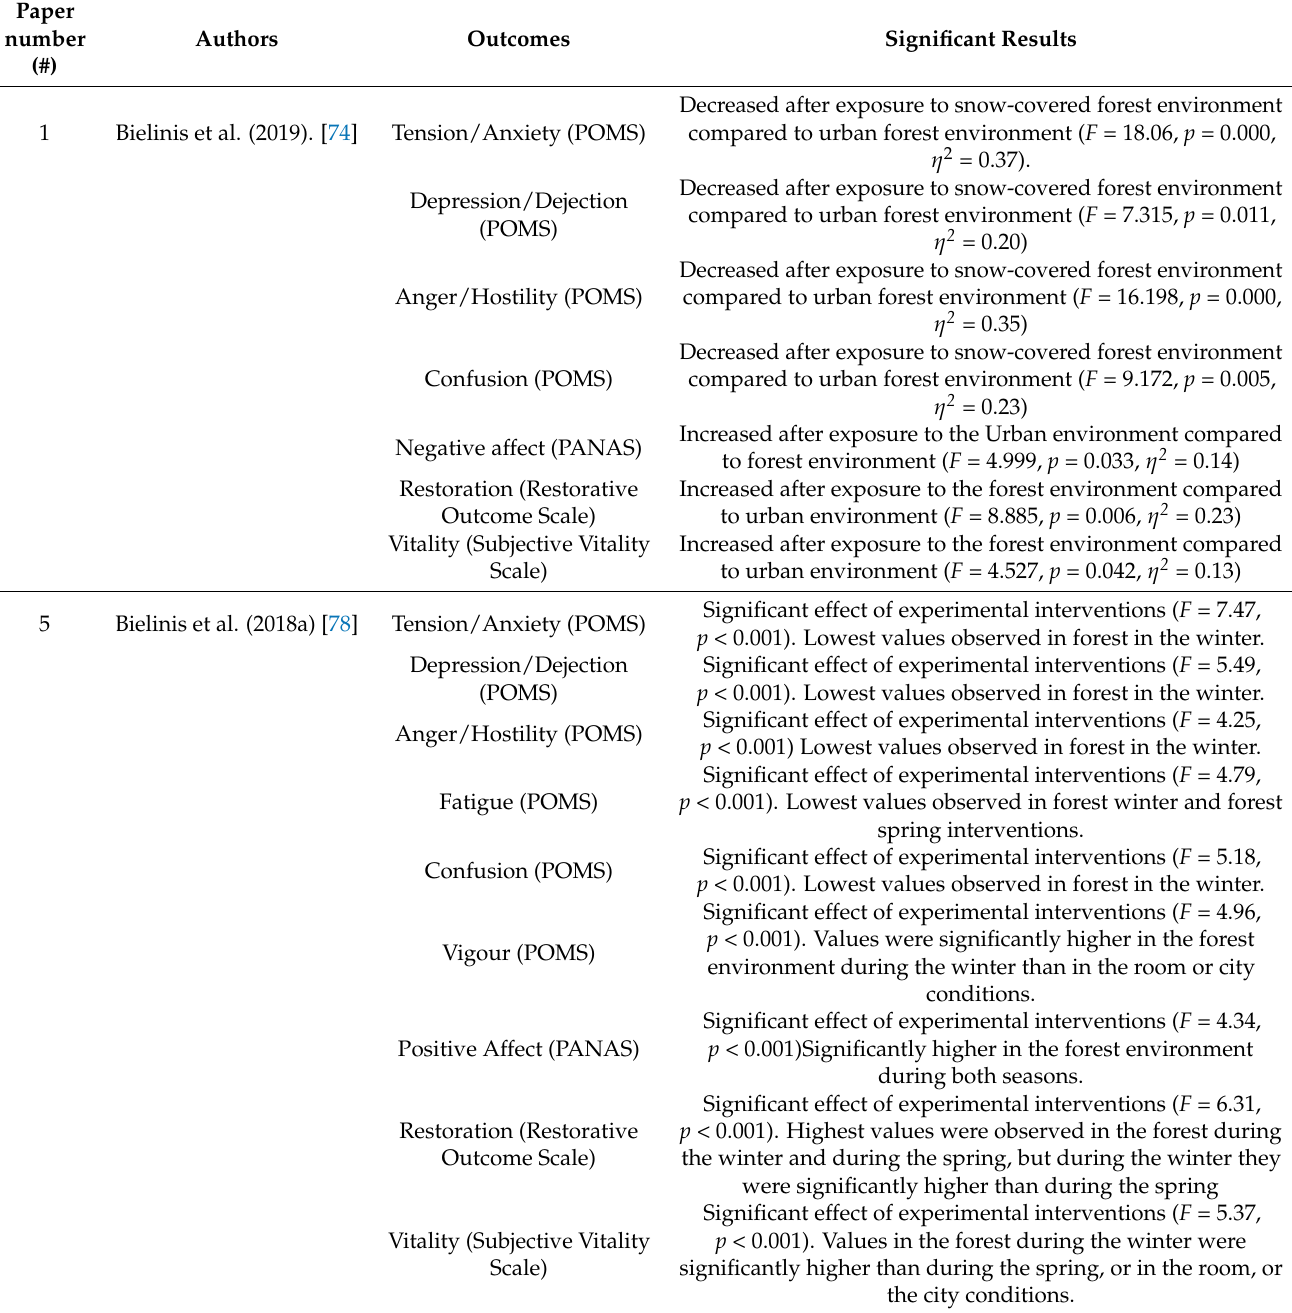
Table 4. Significant outcomes of psychological change following exposure to nature identified in each of the